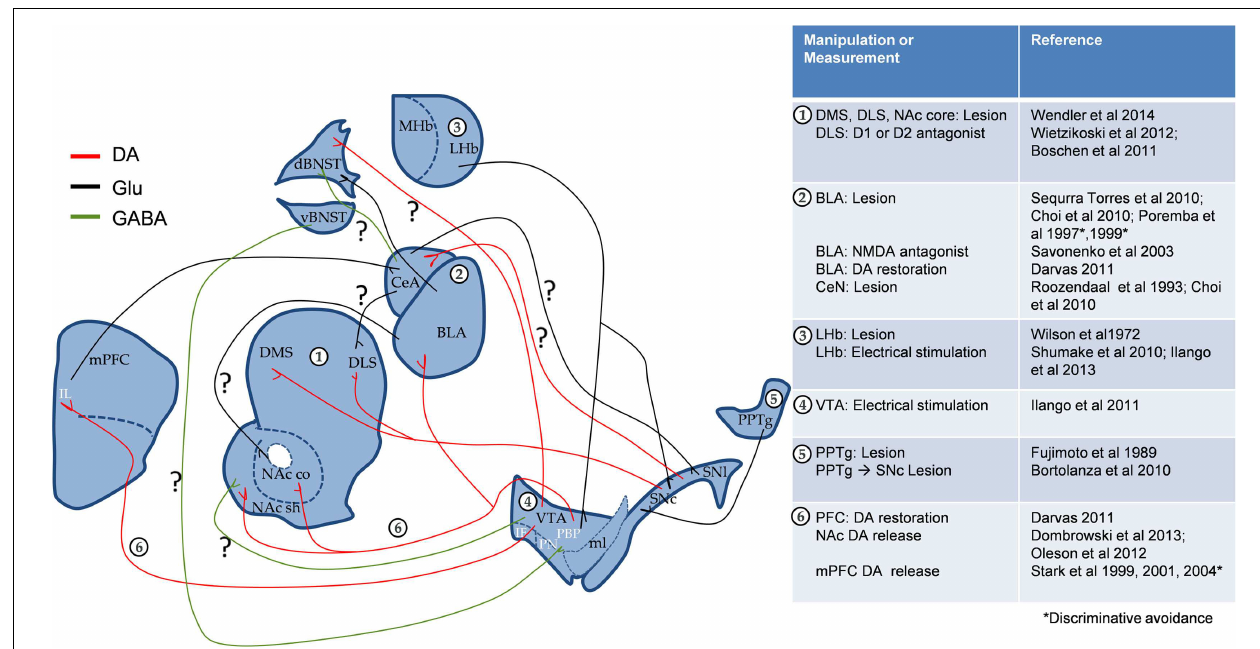
FIGURE 1 | Proposed interaction of emotional and motivational neurocircuitry in cue-signaledAA learning . Apart from the known role of BLA DA in AA, both circuits could interact through direct SNc ← → CeA projections and/or indirectly through striatum and BNST. “?” Denotes the pathways, which could potentially play a role in AA. mPFC, medial prefrontal cortex (IL, infra limbic); NAc, nucleus accumbens (c, core, and sh, shell); VTA, ventral tegmental area (PBP, parabrachial pigmented nucleus; PN,